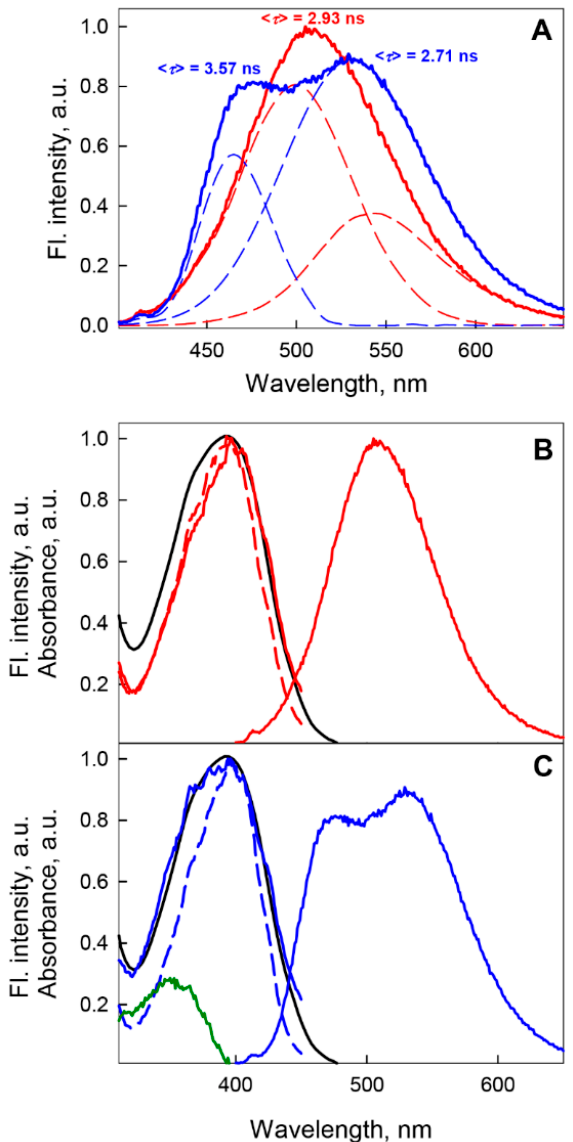
Figure 6. Characteristics of BADAN linked to GGBP/H152C/W183A in apo (red curves) and holo (blue curves) form. Panel ( A ) The fluorescence spectra of BADAN linked to GGBP/H152C/W183A (solid curves) and their decomposition into components (dashed curves); the excitation wavelength was 387 nm. Panels ( B , C ) The excitation spectra of fluorescence recorded at 475 nm (dashed curves) and 540 nm (solid curves). The result of subtraction of the excitation spectrum recorded at 475 nm from that recorded at 540 nm is shown by the green curve panel ( C ). Absorption spectrum of BADAN linked to GGBP/H152C/W183A is presented by the black curve. Thus, for BADAN linked to the GGBP/H152C/W183A holoform, the excitation spectrum recorded at 540 nm is a broad band, including that recorded at 475 nm (Figure 6C). This means that BADAN molecules linked to the GGBP/H152C/W183A glucose complex and emitting in the short-wavelength part of the spectrum can also fluoresce in the long- wavelength region. In turn, this indicates a decrease in the energy of the excited state of such dye molecules owing to their relaxation under these conditions, i.e., about the transformation of the PICT state of BADAN into